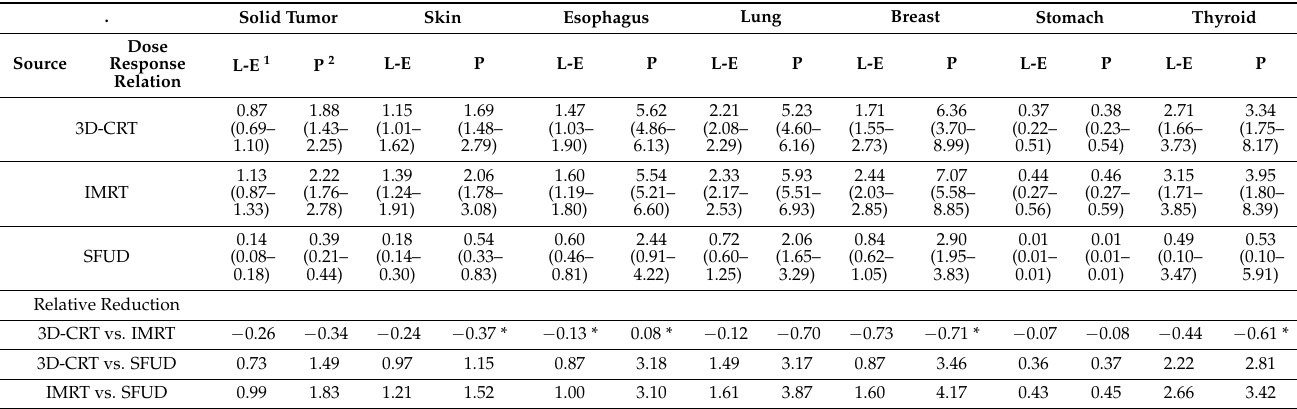
Table 4. OED (Gy). Median values and the values of the first and third quartile are also